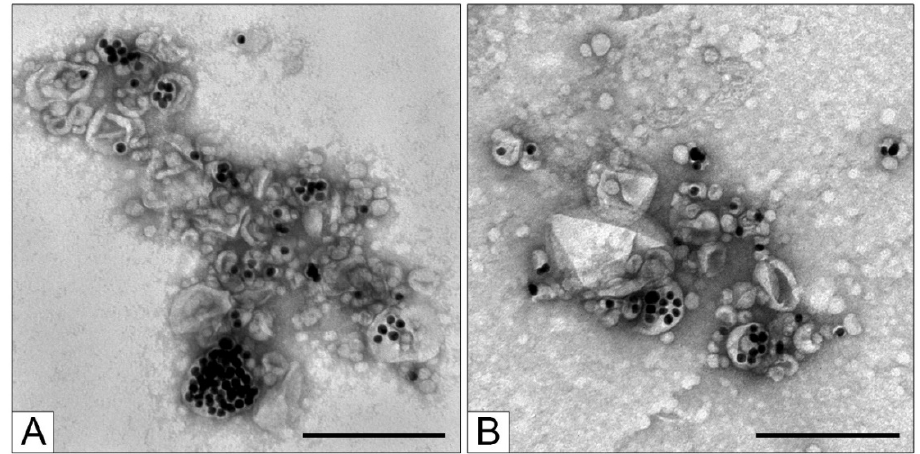
Figure 5. Ultrastructure of the MLNCs obtained in the presence of 0.1 mM MgSO 4 . ( A ) MLNCs prepared via the addition of 10 mM NaCl or ( B ) 5 mM NaCl. The scale bars correspond to 200 nm. Negative staining with a 0.5% uranyl acetate solution followed by TEM.